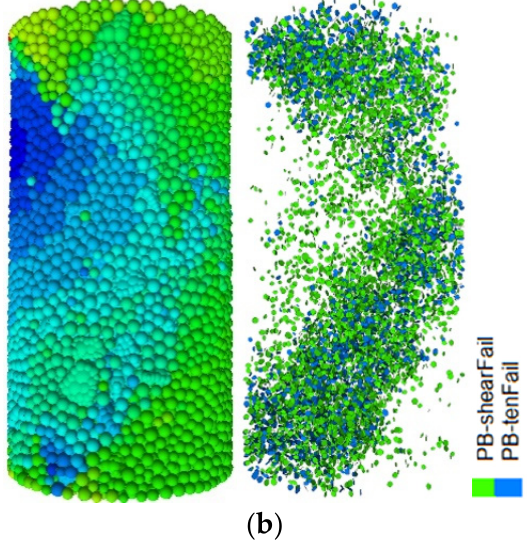
Figure 12. ( a ) Test failure mode; ( b ) Model failure mode and internal crack development (RAC20, confining pressure 2.5 MPa).